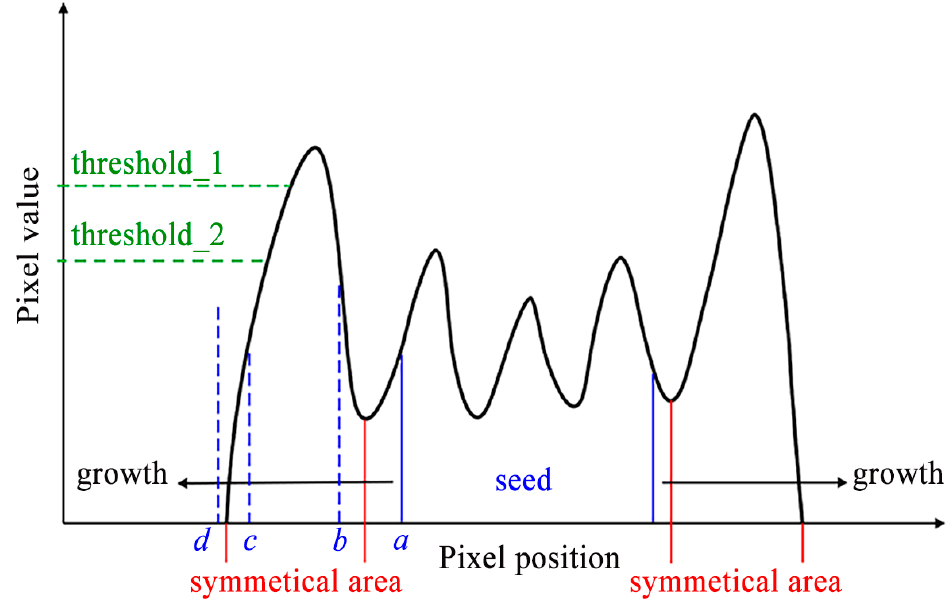
Figure 4. Four types of seed regions in the seed growth: a-d represents four typical positions of seed boundary.